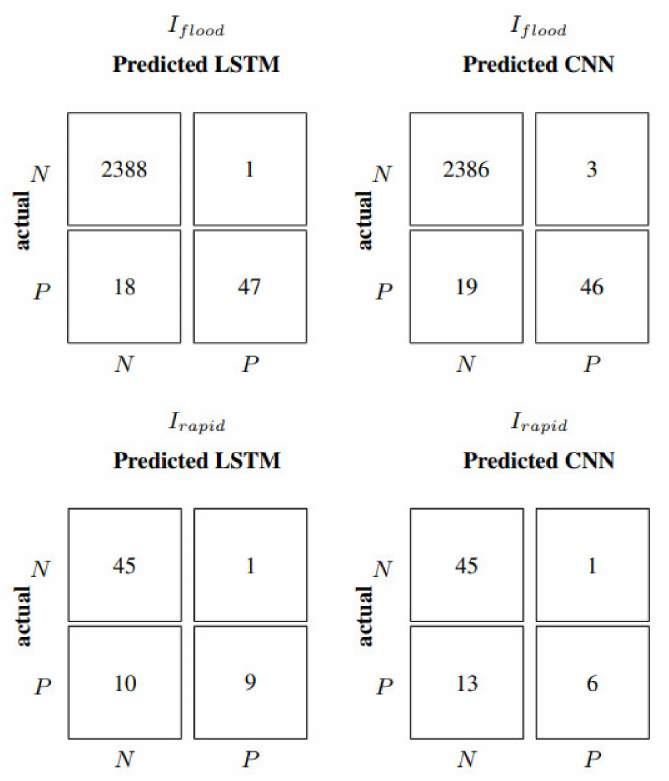
Figure 7. I flood and I rapid for multivariable LSTM and CNN models in the rain gauges scenario. Test data, Lura River. P means a flood or a rapid event is present, N means that it is